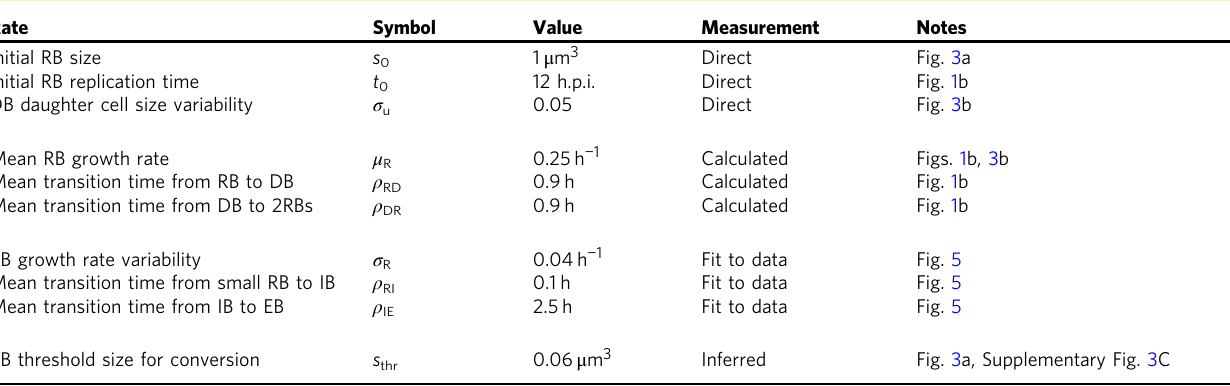
Parametervalues used inthe stochastic mathematicalmodel of cell fateregulationthrough size control. For each parameterwe indicate whetherits value was directly measured,calculated, or fi t so that the model dynamics (Fig. 5) are consistent withexperimental data.For instance, the DB daughter cell sizevariability σ u is measured as the standarddeviationof the data in Fig. 3b. The RB threshold size for conversion is inferred from the mean IB size at 24 h.p.i. (Supplementary Fig. 3A), and the size of a small RB (10th percentile) in a 24 h.p.i. inclusion (Fig.